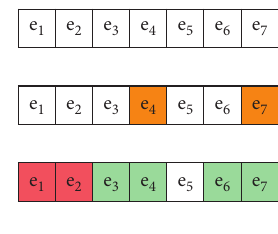
Figure 7: The proposed event stream windowing algorithm. Source: own